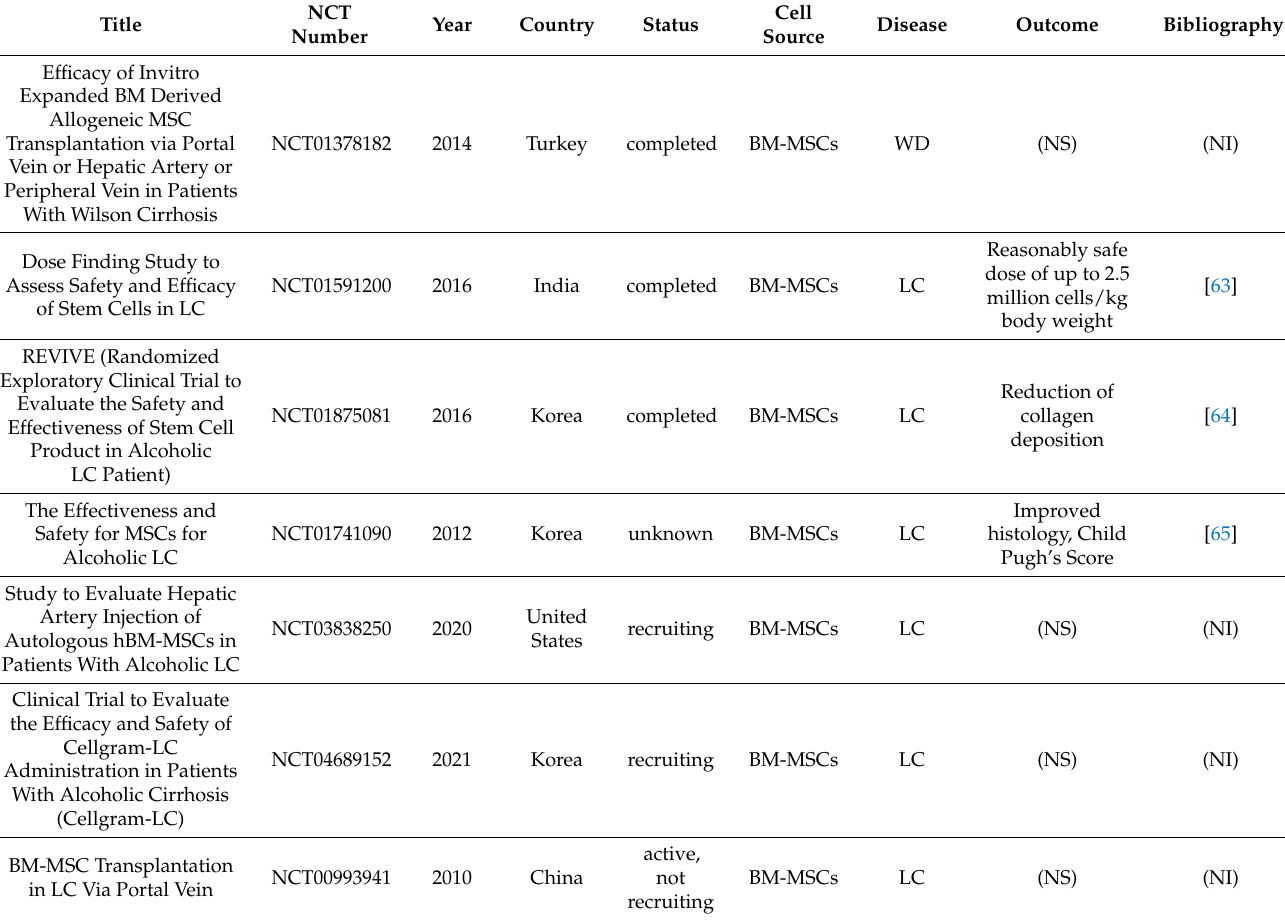
Table 1. Clinical Trials using MSCs and LPCs in Liver